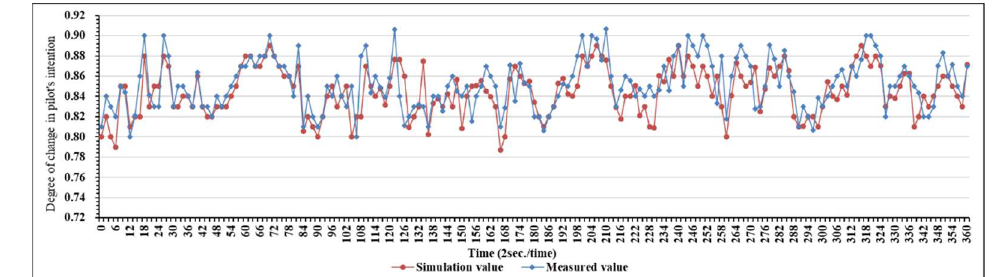
Figure 9. Comparison chart of a pilot’s intention simulation value and measured value .